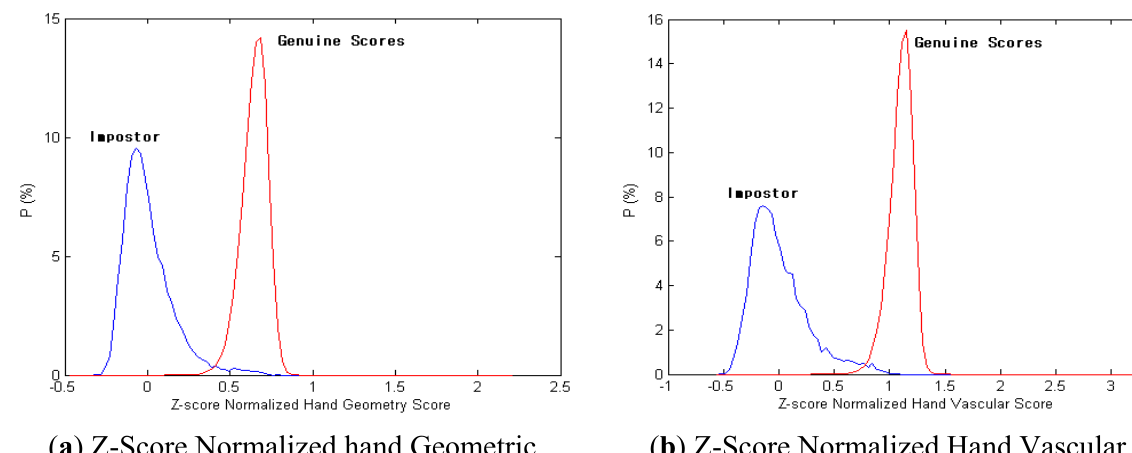
Figure 14. Distribution of genuine and impostor scores after z-score Normalization ( a ) hand geometry; ( b ) hand vascular pattern.